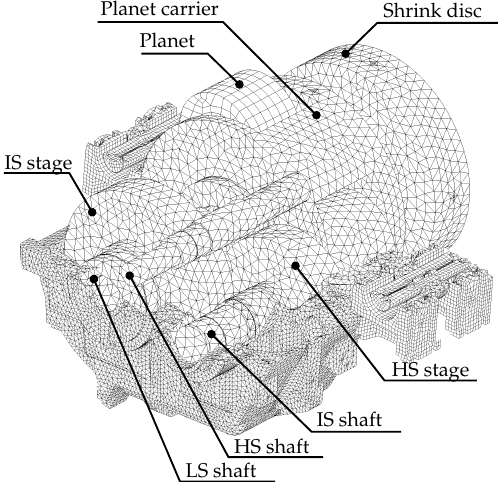
Figure 11. FE model with internal components of the three-staged gearbox with a low-speed (LS) planetary stage and a intermediate speed (IS) as well as a high-speed helical